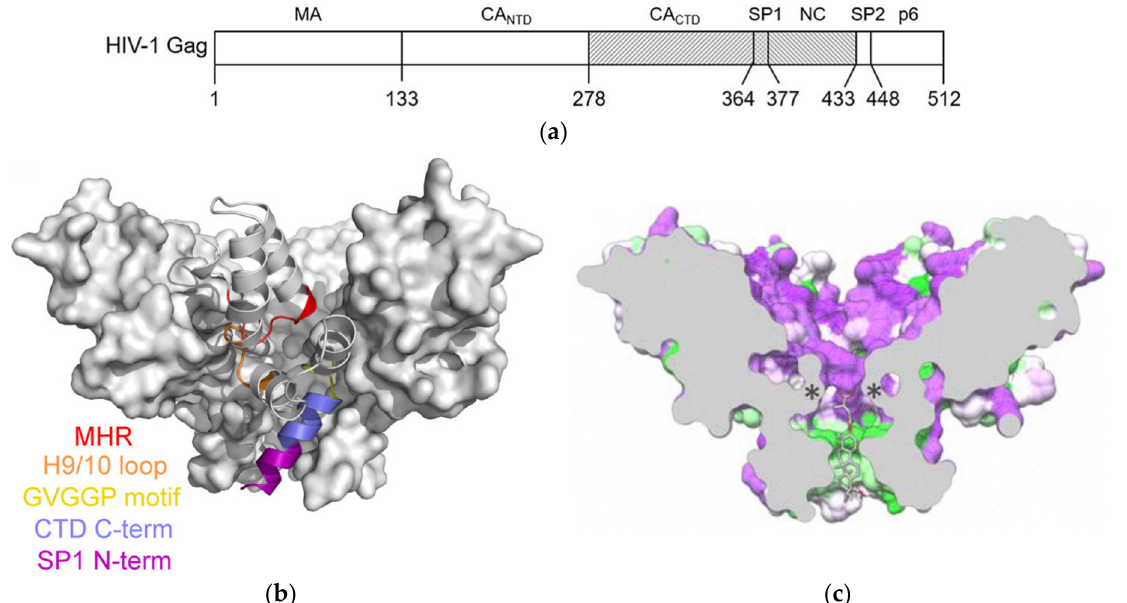
Figure 1. Schematic representation of the HIV-1 Gag precursor protein and BVM binding to CA CTD - SP1 (adapted from [8,12,15] with permission). ( a ) The HIV-1 Gag precursor protein; ( b ) side views of CA CTD -SP1; ( c ) BVM binding to CA CTD -SP1 [hydrophobic (green) to polar (purple) interactions and the asterisk indicates the position of key residue K359].